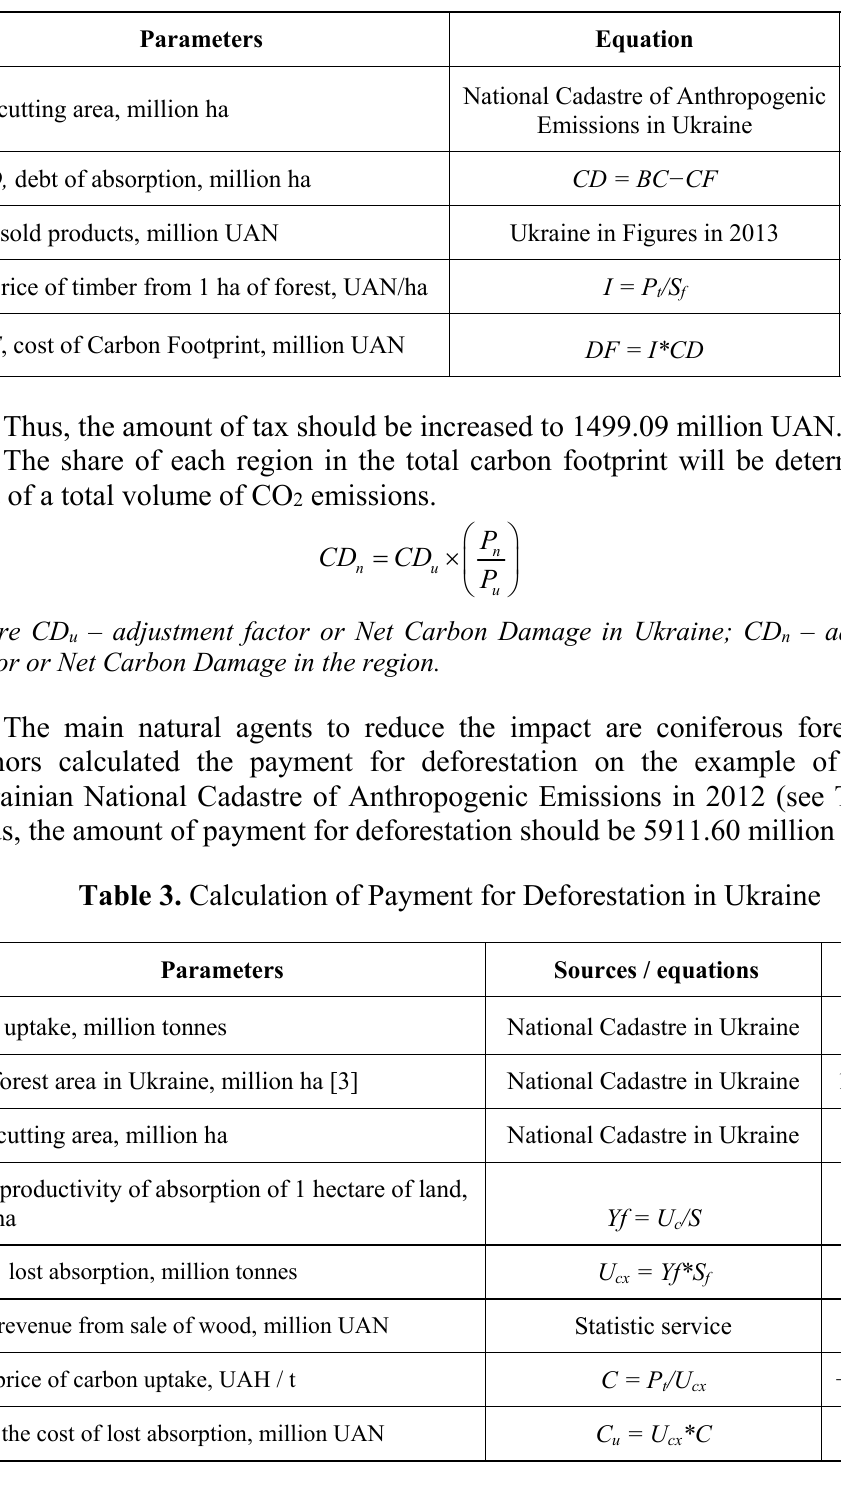
Table 2. Calculation of Cost of Carbon Footprint (Nekrasenko, Prokopenko, & Aranchiy, 2015)